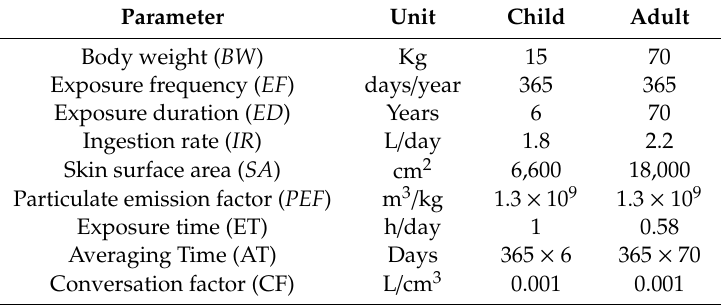
Table 2. Parameters used for the health risk assessment through di ff erent exposure pathways of water